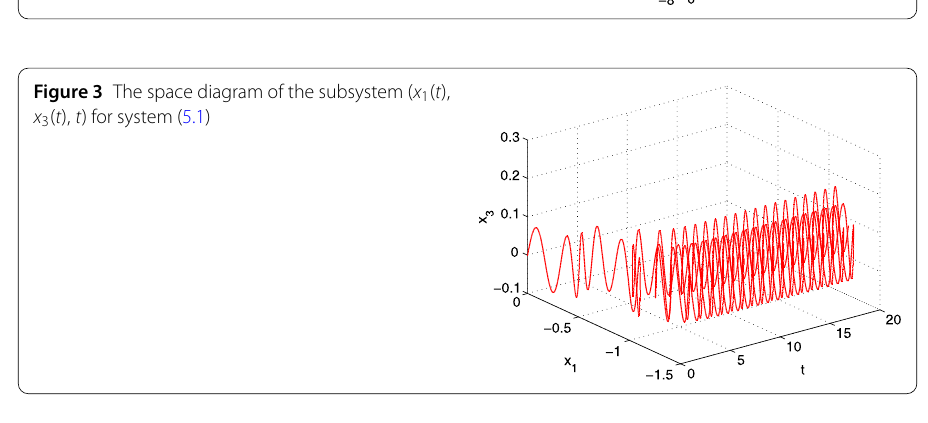
Figure 4 The space diagram of the subsystem ( x 2 ( t ), x 3 ( t ), t ) for system